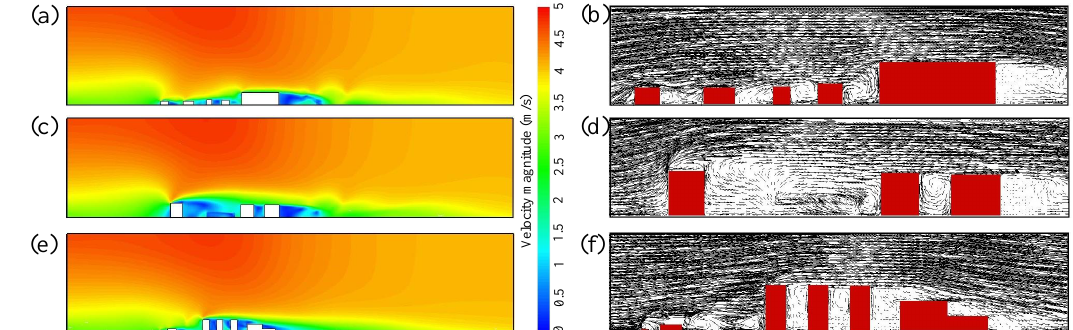
Figure 6. Velocity distribution characteristics on different vertical planes: ( a ) velocity contour and ( b ) velocity vector diagram of y = 0 m; ( c ) velocity contour and ( d ) velocity vector diagram of y = − 50 m; ( e ) velocity contour and ( f ) velocity vector diagram of y = 100 m.